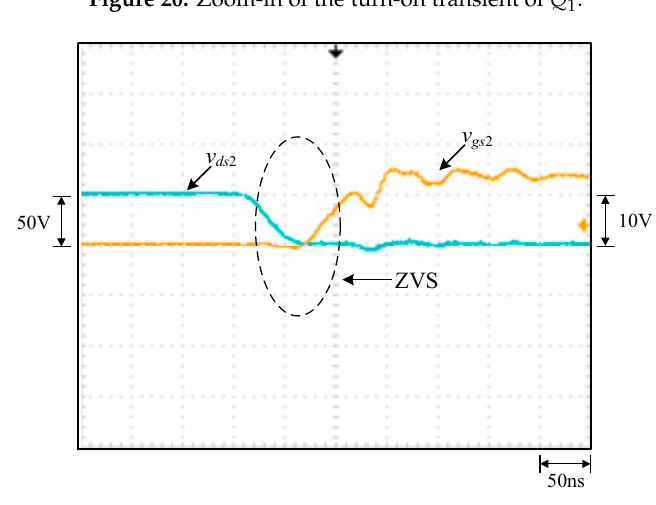
Figure 21. Zoom-in of the turn-on transient of Q 2 .